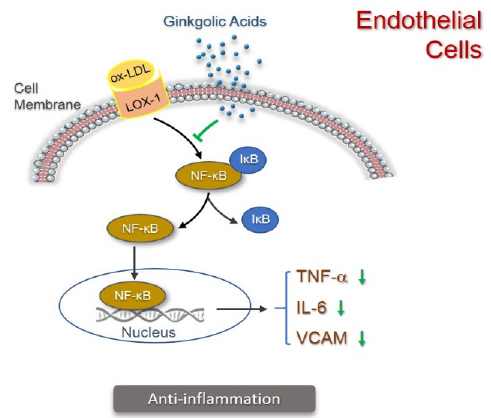
Figure 5. Anti-inflammation activity of ginkgolic acids in endothelial cells. Binding of oxidized low-density lipoprotein (oxLDL) to its transmembrane protein Lox-1 triggers release of NF- κ B from its inhibitor I κ B and migration of NF- κ B to nucleus, thus enhancing transcription of TNF- α , IL-6, and VCAM-1 (illustrated in black). Ginkgolic acids inhibit NF- κ B signaling, thereby inhibiting the production of TNF- α , IL-6, and VCAM-1 (illustrated in green).